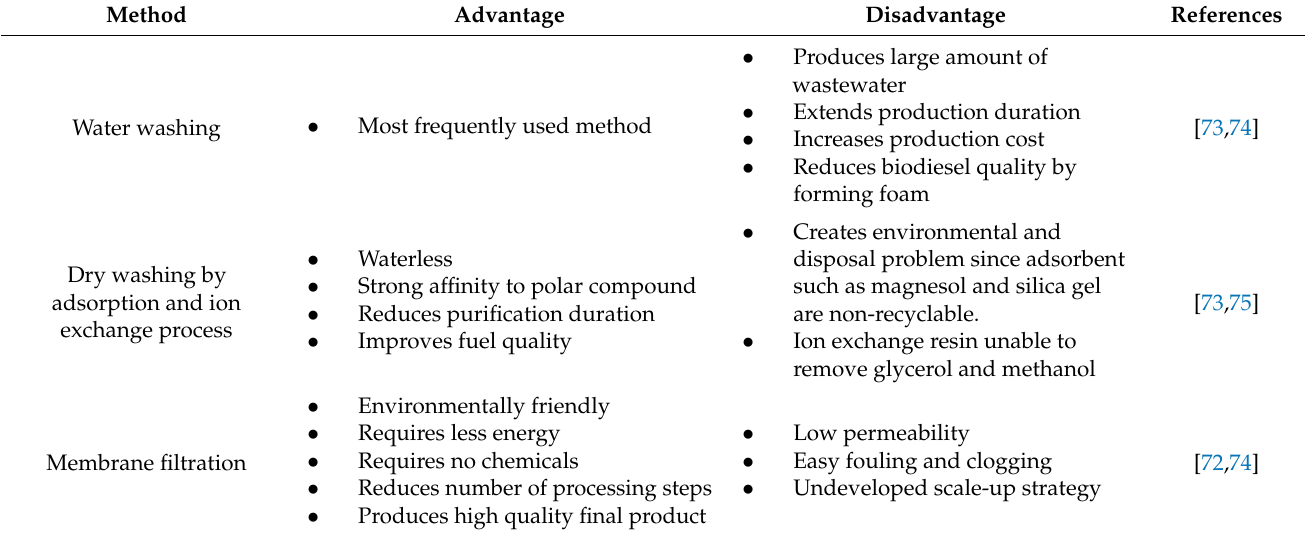
Table 5. Comparison of different methods in biodiesel